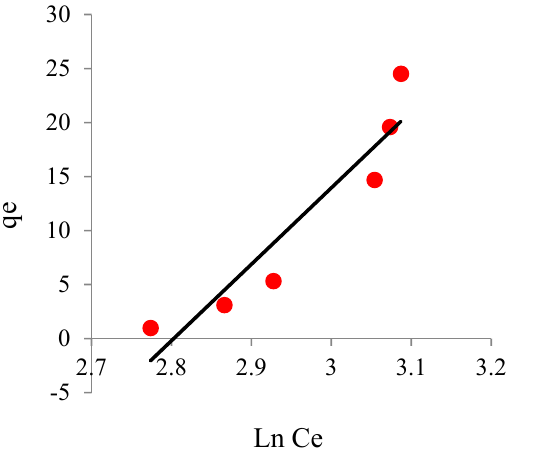
Fig. 11: Temkin adsorption isotherm of cadmium ions onto polypyrrole/titanium dioxide nanocomposite.